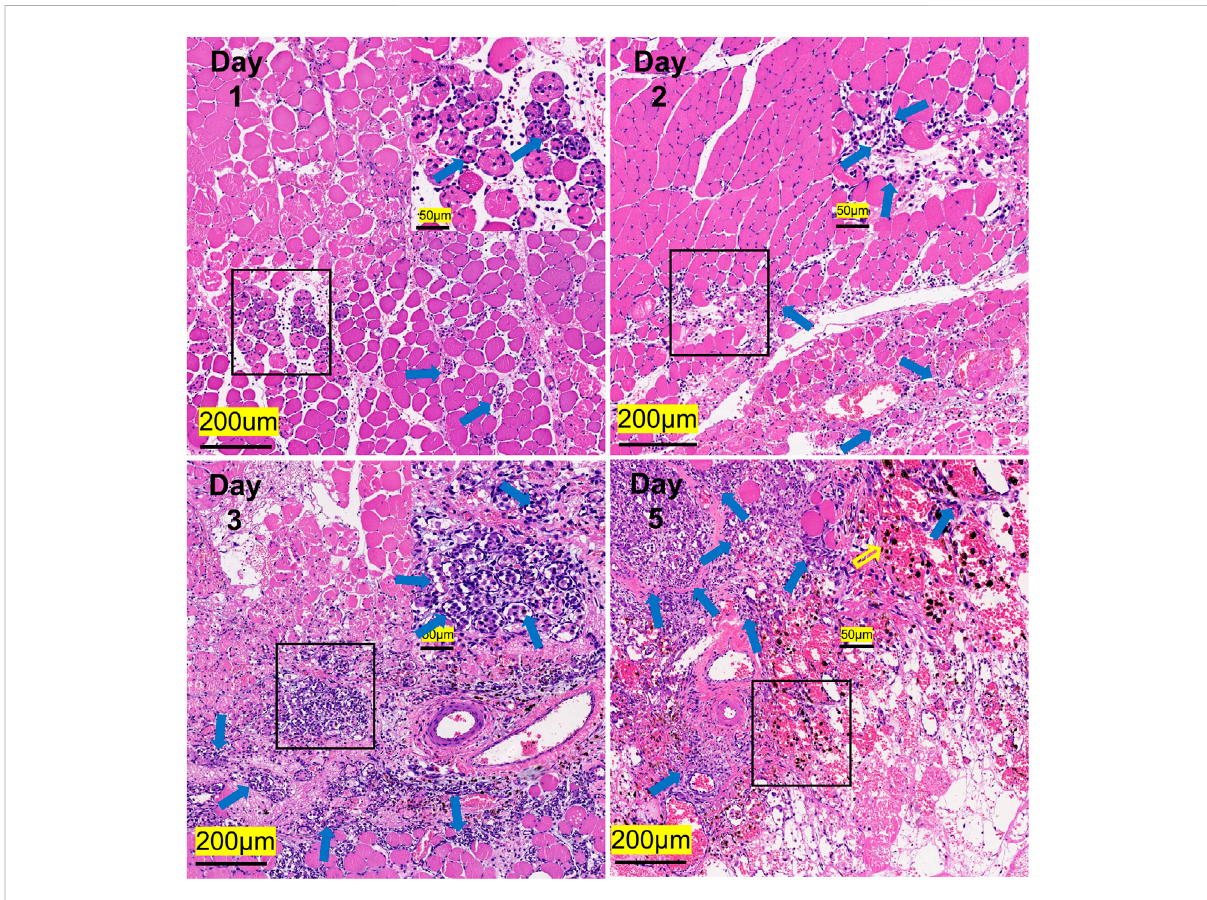
FIGURE 7 Representative HE staining images of the gastrocnemius at different times after the injury ( n = 20). Scale bar = 200 μ m. (Blue hollow arrows indicate in fl ammatory cells, and the yellow indicates